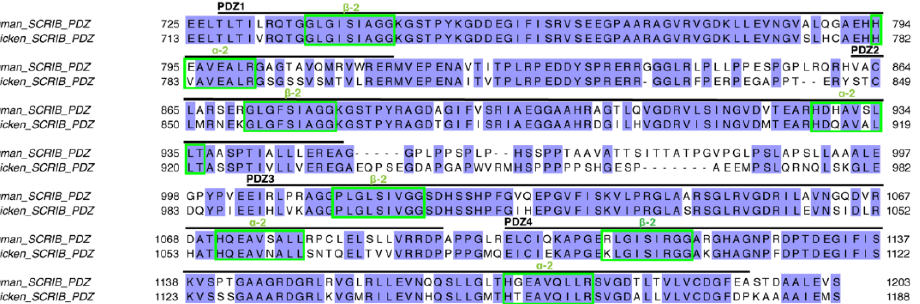
Figure 7. Sequence alignment of human and avian Scribble (Uniprot accession number Q14160 for human SCRIB and Genbank accession number XM_040696172.1 for chicken SCRIB). Conserved residues are shaded in lilac, key regions mediating interactions with NS1 are boxed in green.